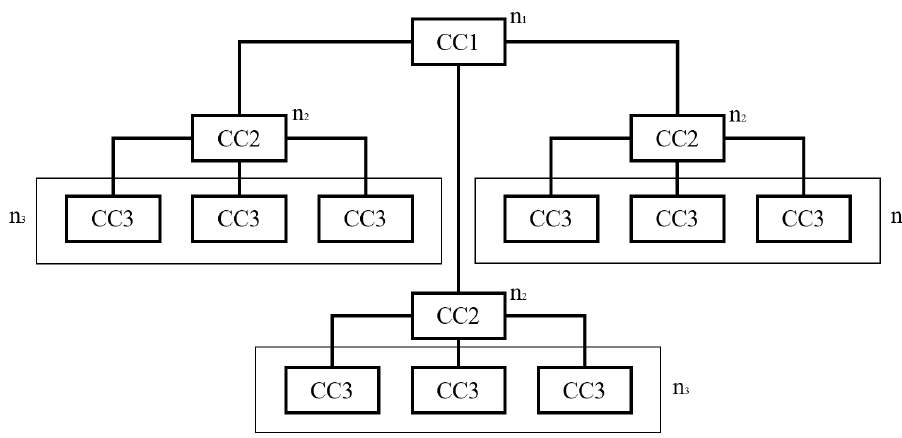
Figure 1. The investigated control system of a dynamic OTS.